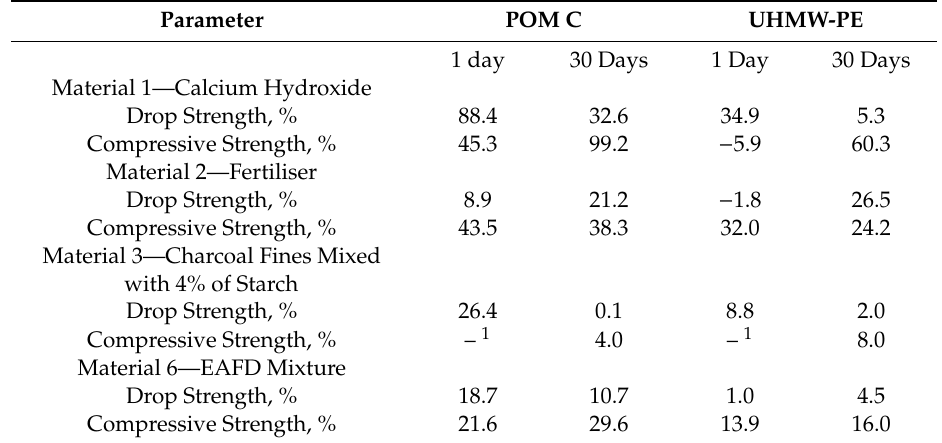
Table 4. Percent change of the compressive strength and of the average drop strength against the results obtained with no linings